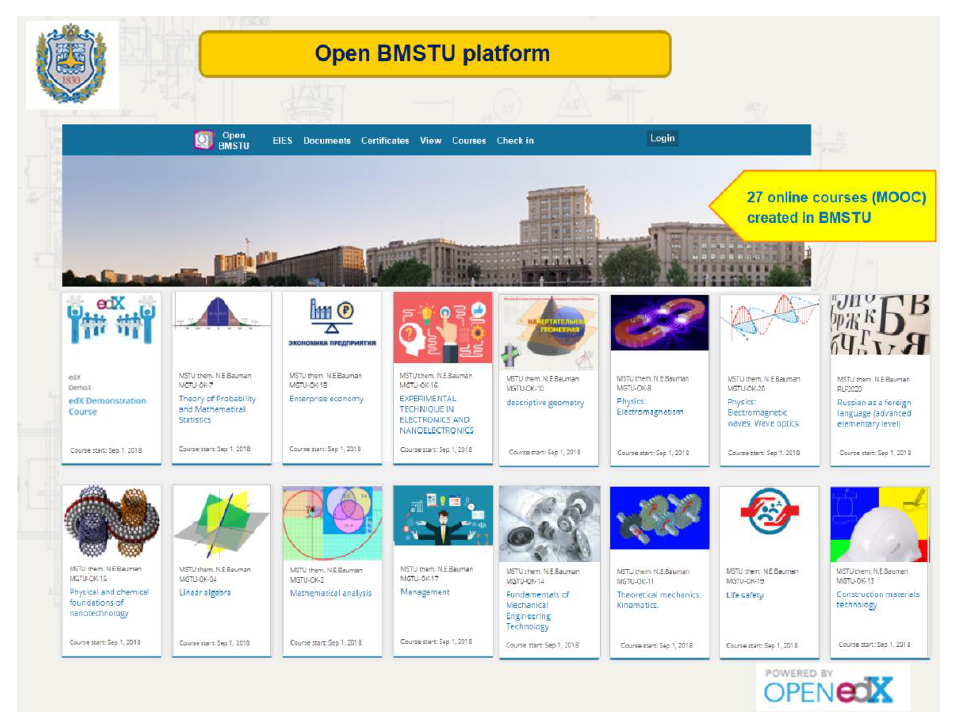
Fig. 2. The BMSTU-online platform (subsystem of the Open BMSTU